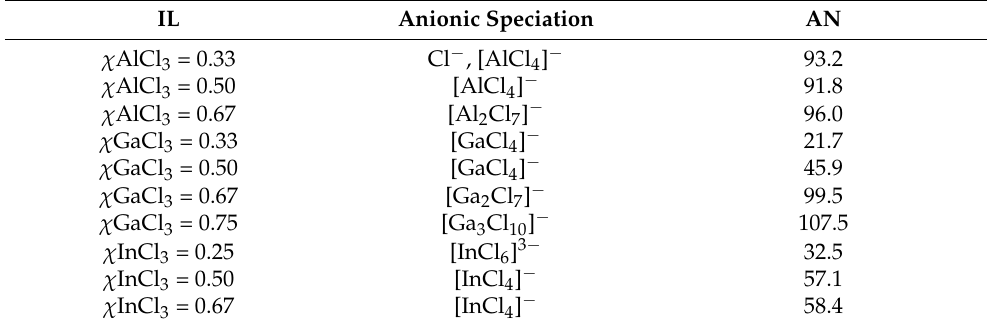
Table 2. Series of anionic spicies and acceptor numbers for selected chlorometallate(III) ionic liquids based on [C 8 mim] + cation